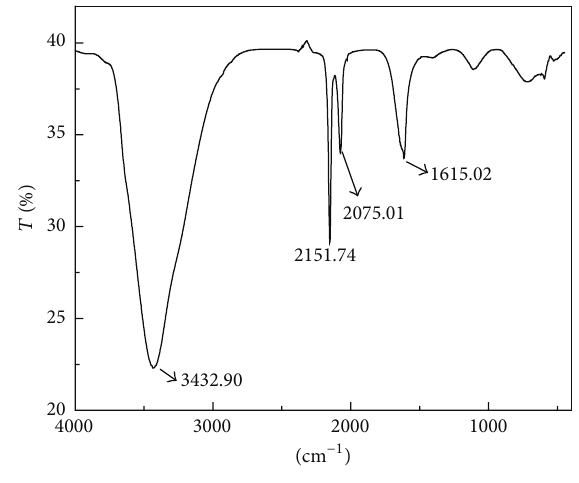
Figure 2: FT-IR spectrum of the compound.